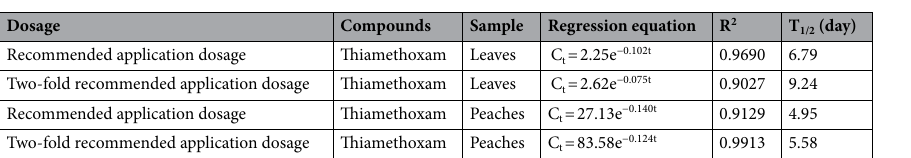
Table 4. Regression equations, half-lives (T 1/2 ) and correlation coefficients (R 2 ) for the dissipation of thiamethoxam at different application dosage by foliar